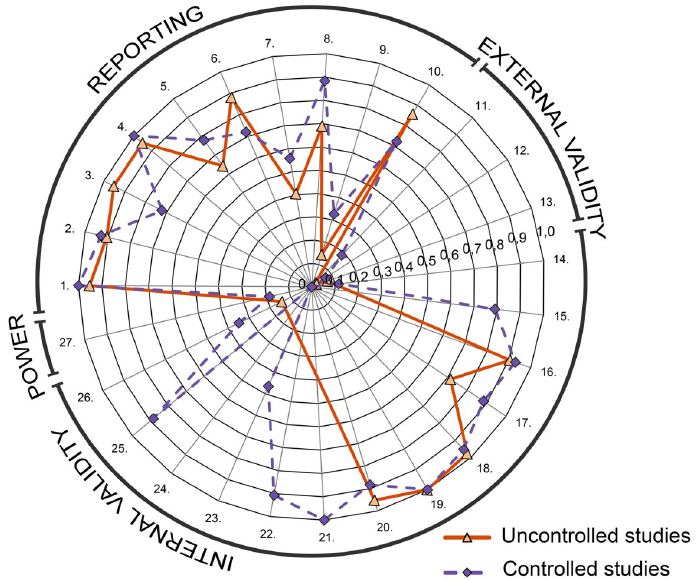
Fig 5. Mean Downs and Black checklist scores per item for controlled and uncontrolled studies. Item numbers are indicated within the outer ring. For uncontrolled studies, items 14, 15, 21–25, and 27 were considered irrelevant and were therefore omitted. All scores are normalized to 1 inasmuch as one item (#5) has a maximum score of 2 instead of 1.